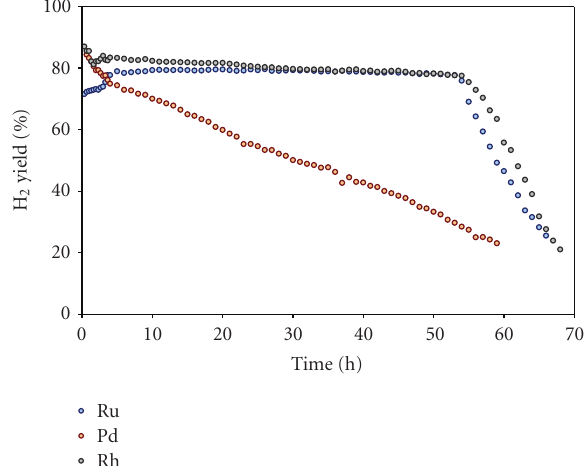
Figure 8: Comparison of hydrogen yield in kerosene reformates using di ff erent